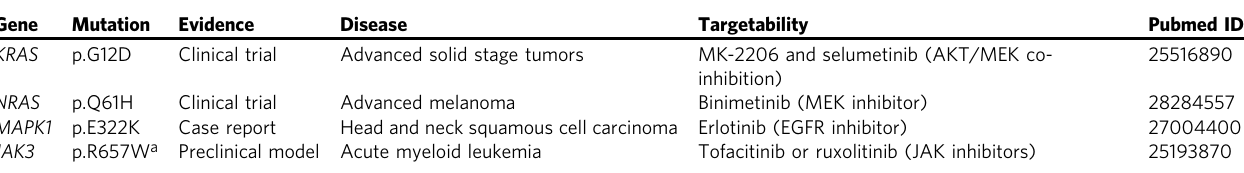
a Indicates mutation involving same amino acid position, but not same amino acid change,